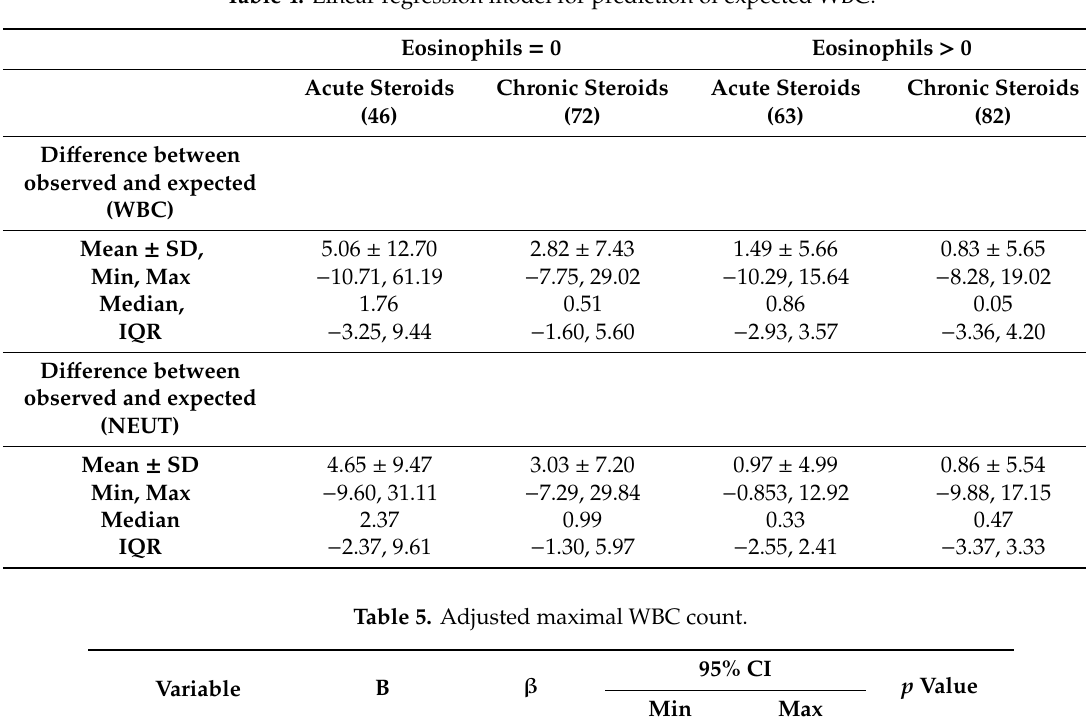
Table 4. Linear regression model for prediction of expected WBC.